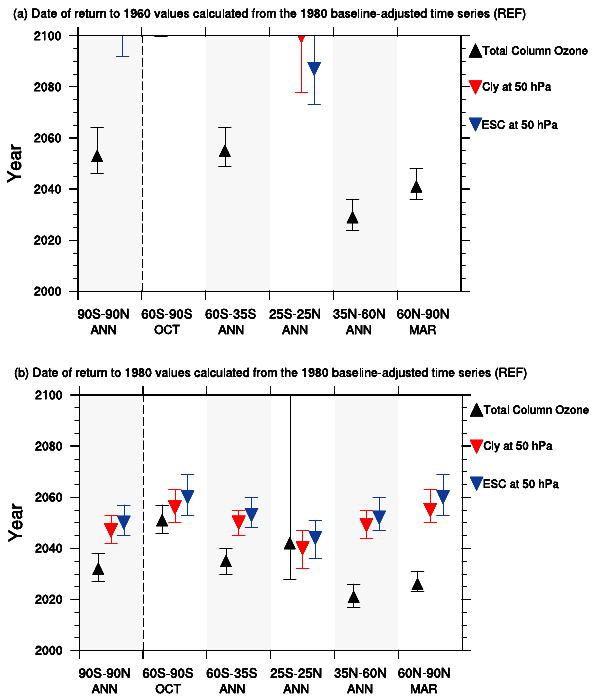
Fig. 10. Date of return to 1960 (upper panel) and 1980 (lower panel) total column ozone (black triangle and error bar), Cl y at 50hPa (red triangle and error bar) and ESC at 50hPa (blue triangle and error bar) for the annual average (global, tropical and midlatitude) and spring (polar) total column ozone derived from the 1980 baseline- adjusted CCMVal-2 reference simulations (17 CCMs) in each lat- itude band. The error bar shows the uncertainty in return dates as calculated from the 95% confidence interval. ESC is calculated as Cl y + 60 × Br y except for E39CA (see text). While a few models project a return of tropical total column ozone to 1980 levels, most do not with the result that the 95% TSAM confidence interval ex- tends from 2030 to beyond the end of the century which explains the large error bar in the tropical column ozone return dates in the lower